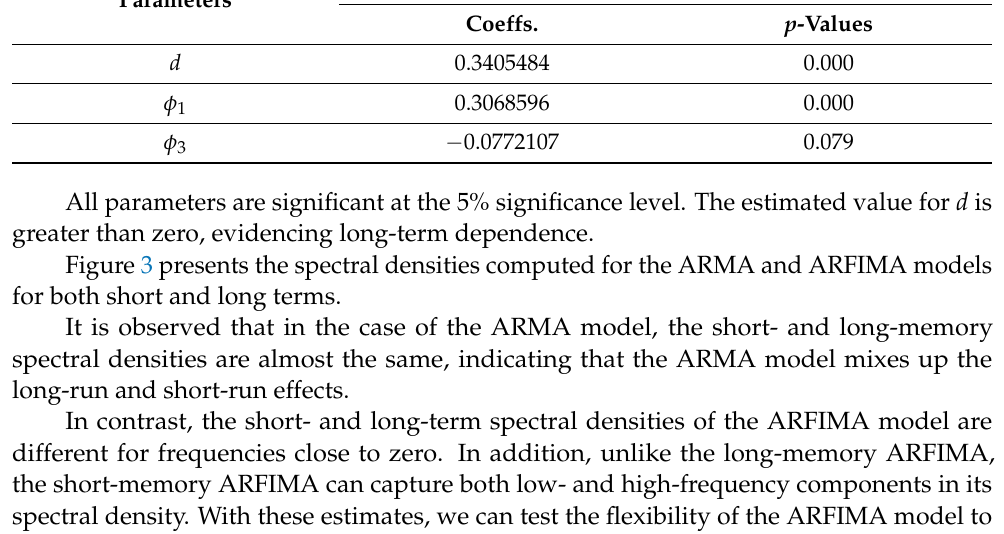
Table 2. ARFIMA model parameter estimation.